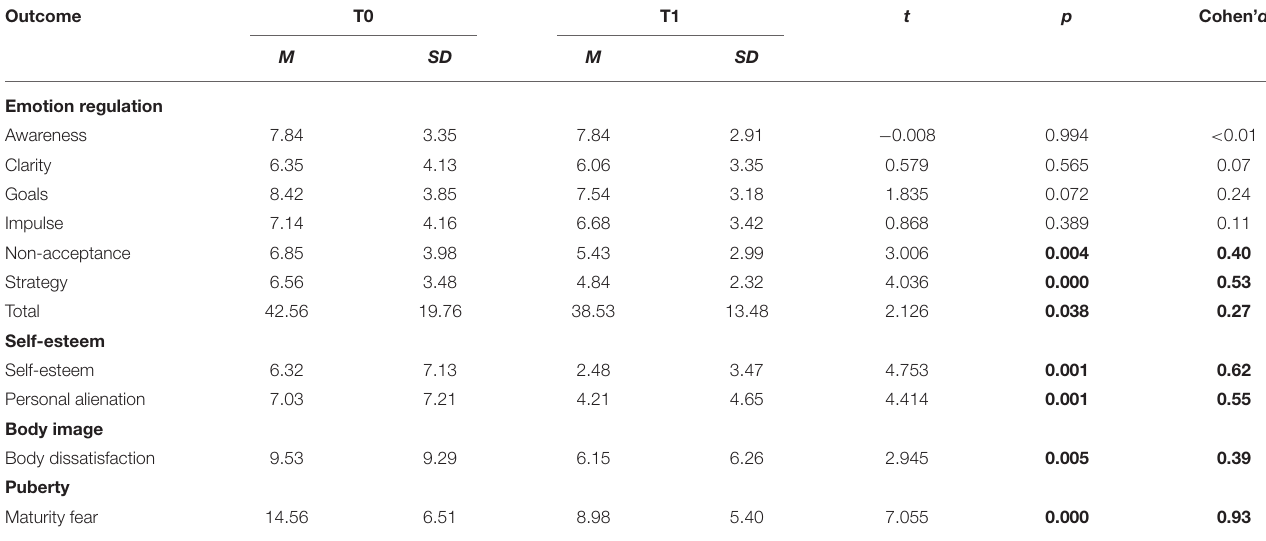
TABLE 1 | Descriptive statistics and t -test results for the study. Outcome T0 T1 t p Cohen’ d M SD M SD Emotion